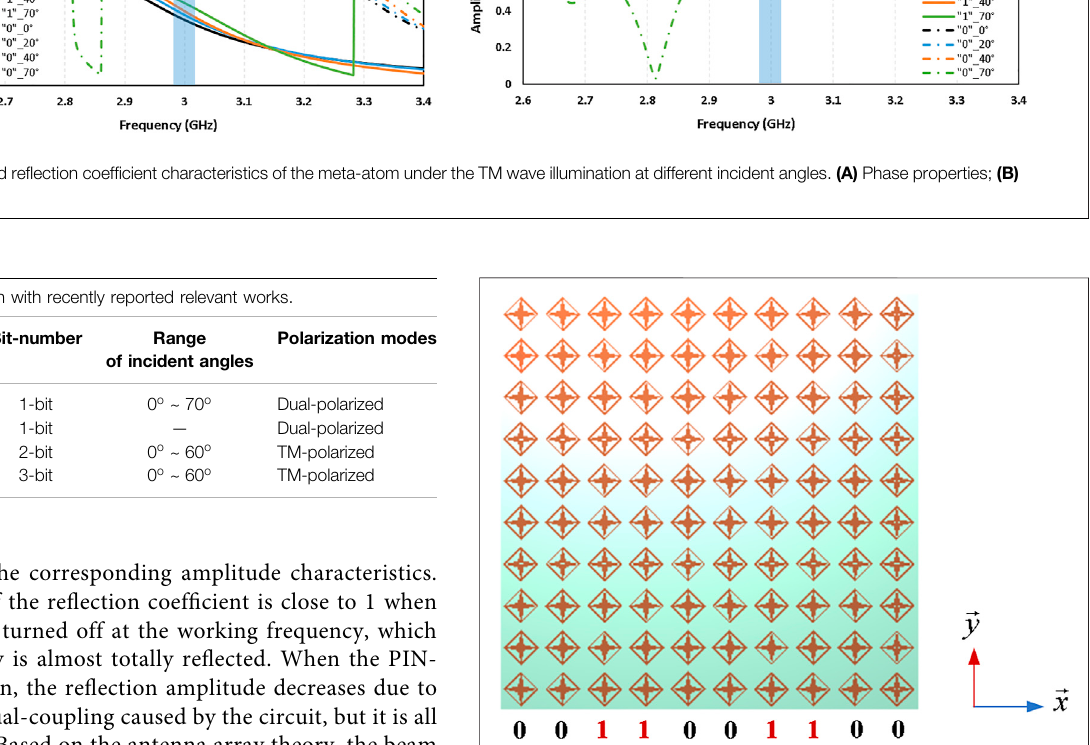
FIGURE 4 | Sketch of a 10*10 array and its coding